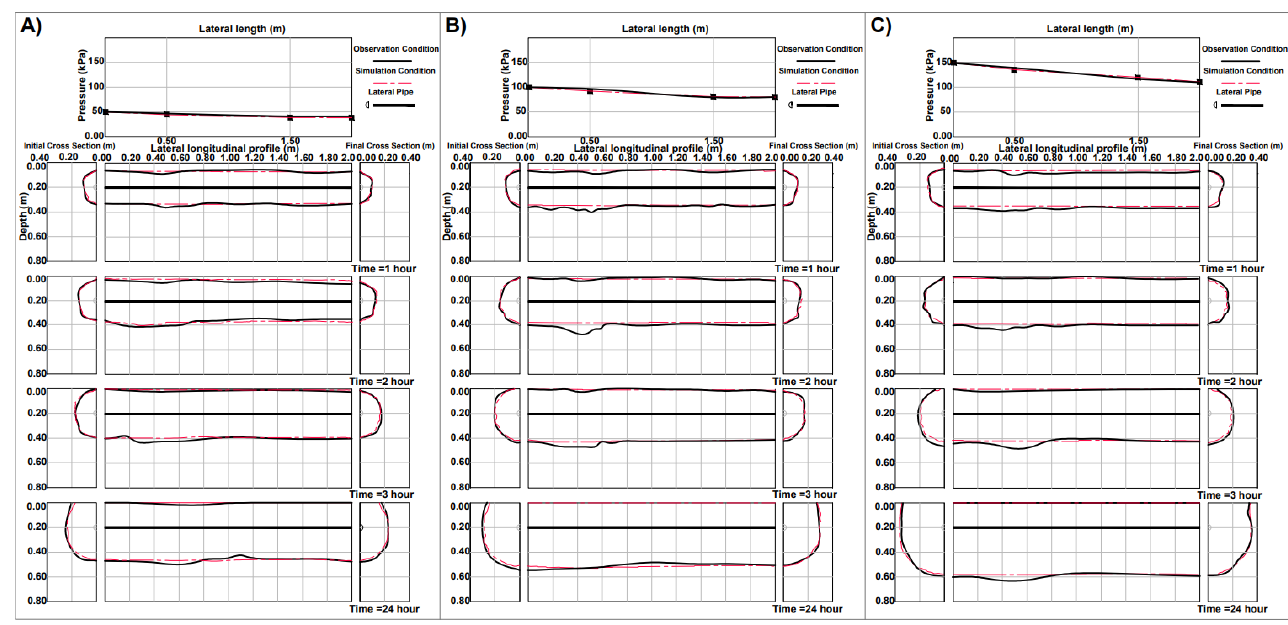
Figure 6. Comparison between observed and simulated wetting fronts for drip lateral with 40 cm emitter spacing at operating pressures of ( A ) 50 kPa, ( B ) 100 kPa, and ( C ) 150 kPa.